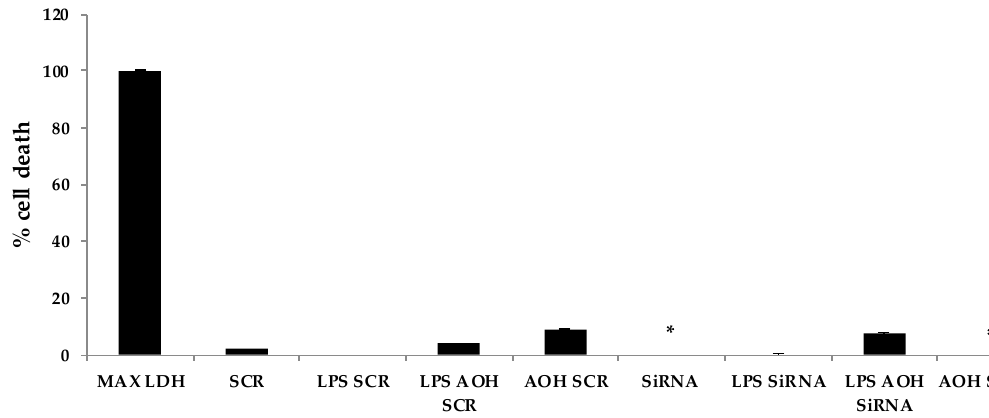
Figure 9. RNA silencing of the aryl hydrocarbon receptor (AhR) gene followed by treatment with lipopolysaccharide (LPS) and alternariol (AOH) in BEAS-2B cells. Cells were seeded at a density of 150,000 cells/well. Cells were treated with AhR siRNA for 24 h twice to successfully knockdown AhR. ( a ) IL8, and ( b ) IL6 released upon treatment with 10 μ M AOH and 10 μ g LPS for 24 h as measured by enzyme-linked immunosorbent assay (ELISA). An * indicates p < 0.05 according to Student’s t -test for AOH treatments (Scr or SiRNA) compared to LPS (Scr) or LPS (siRNA) controls, respectively.